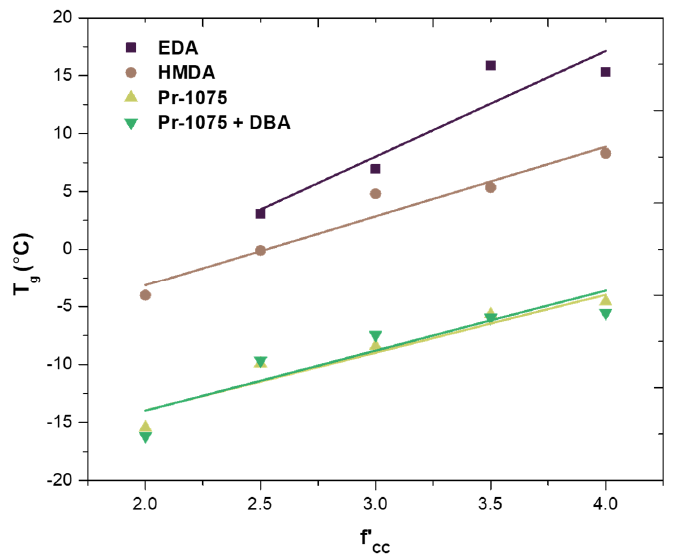
Figure 9. Glass transition temperature (Tg) NIPU values. The T g obtained values are lower than those of conventional polyurethanes, but sim ‐ ilar to those of vegetable oil ‐ derived NIPUs, indicating that they are mostly amorphous.